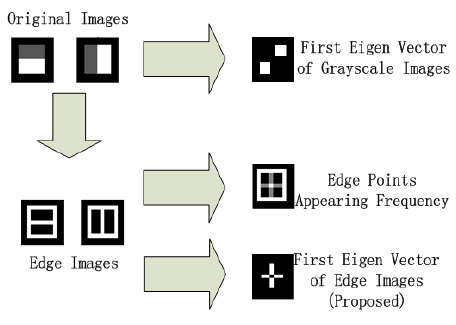
Fig. 1 A simple example of different weighting functions Fig. 2 and Fig.3 give examples of false matching